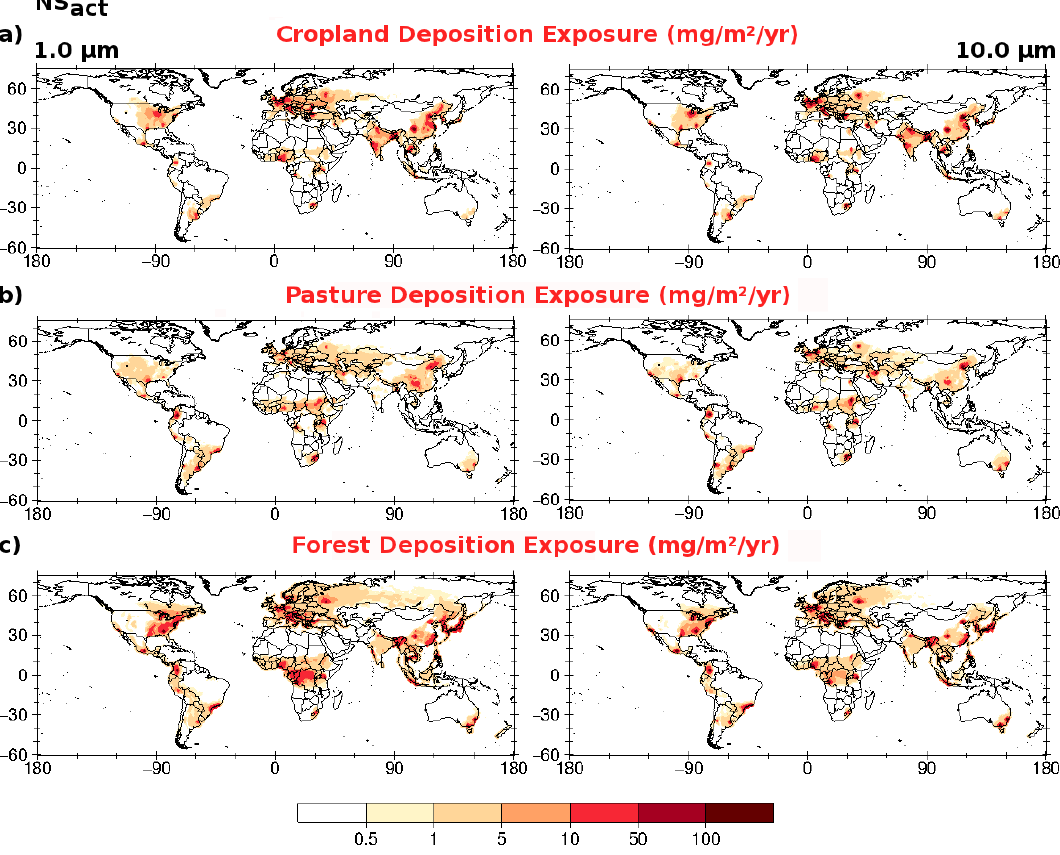
Fig. 7. Folded maps of the sum of all MPC annual accumulated deposition fields (in mgm − 2 yr − 1 ) and the relative fractions of the three ecosystems (see also Fig. S1 in the Supplement). The left side shows the NS act 1 . 0µm aerosol tracers, the right side the NS act 10 . 0µm aerosol tracers.